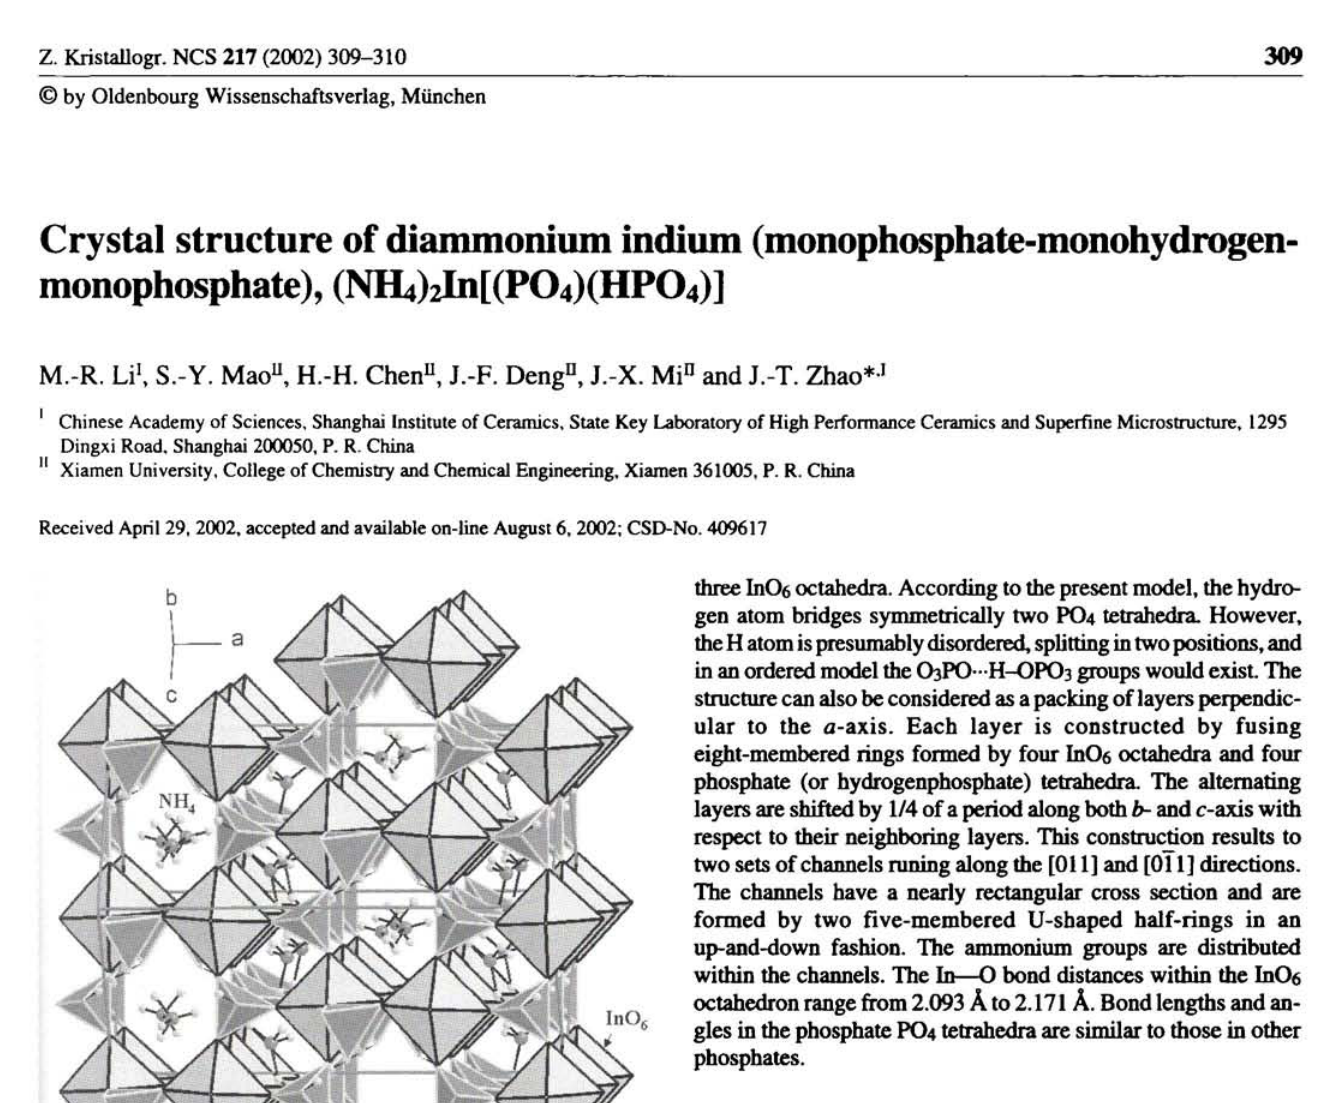
Table 1. Data collection and handling.